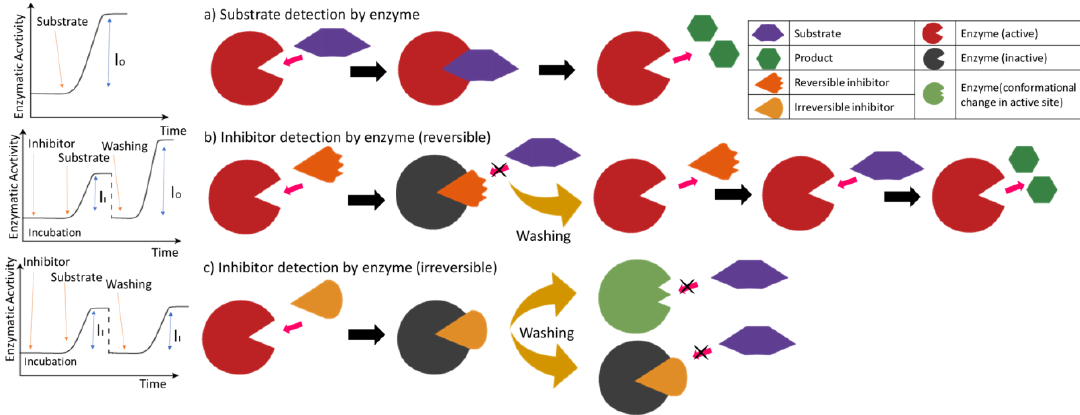
Figure 1. Scheme of enzymatic biosensor for substrate and inhibitor (reversible and irreversible)